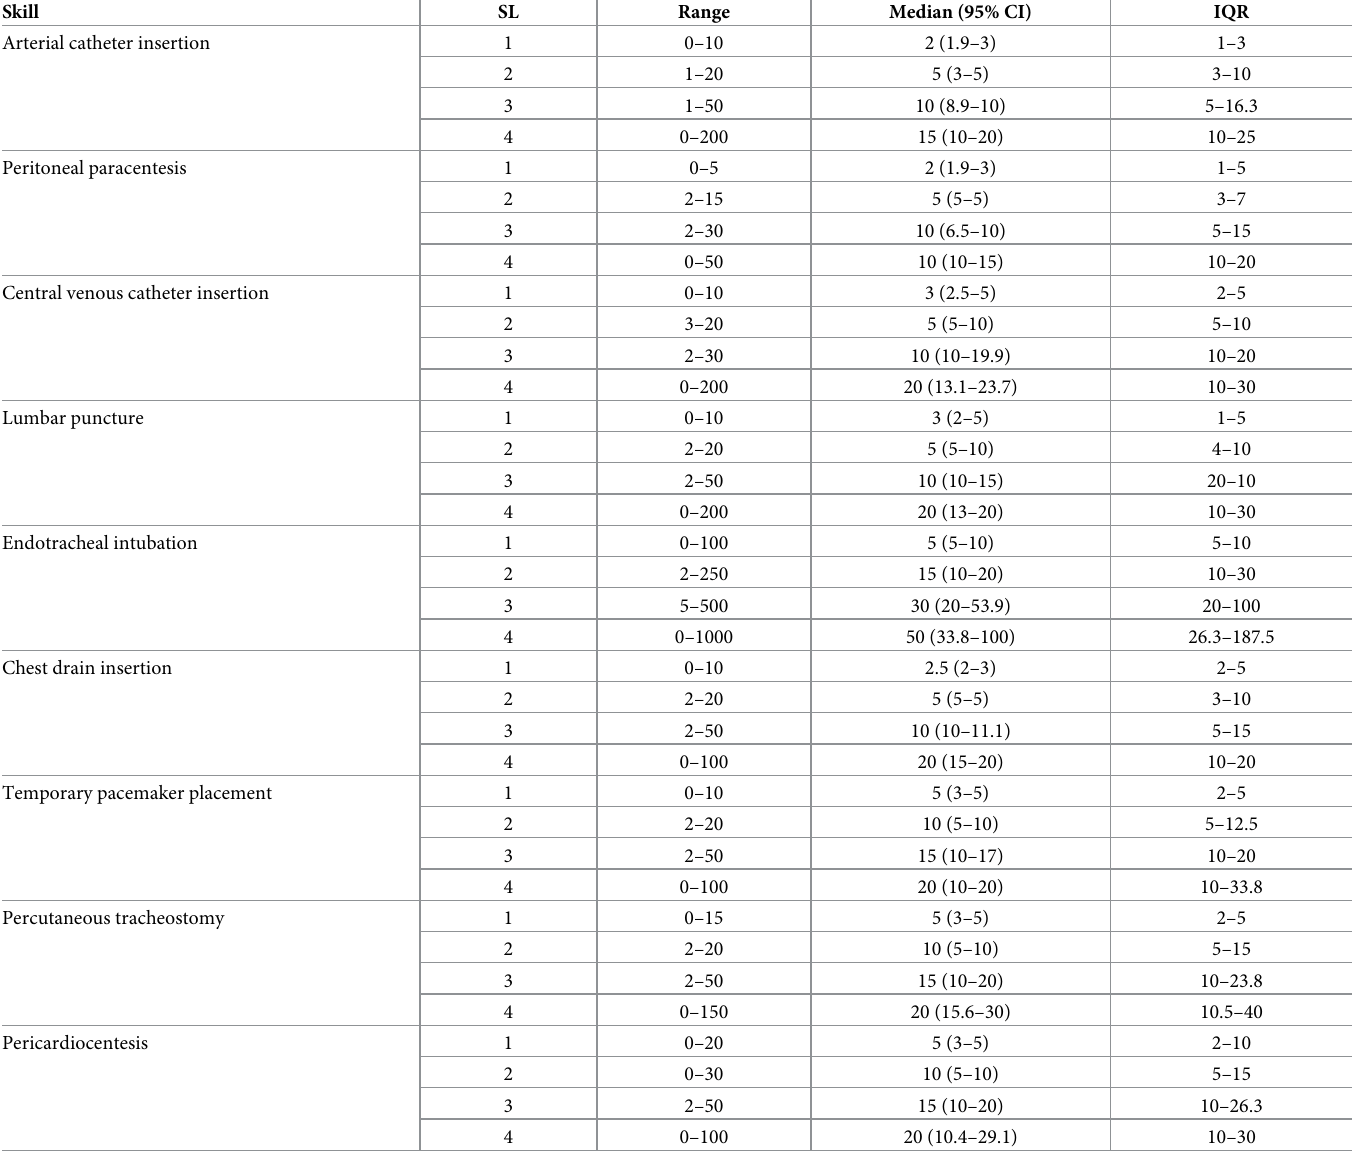
Table 5. Number of skill repetitions required to move up to next supervision